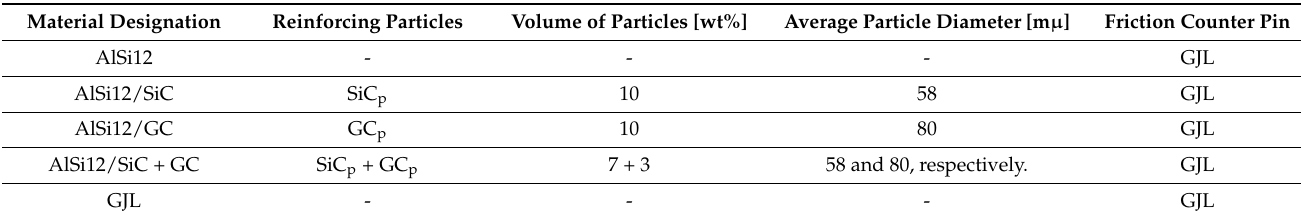
Table 3. Designation of samples and friction pairs used in tribological